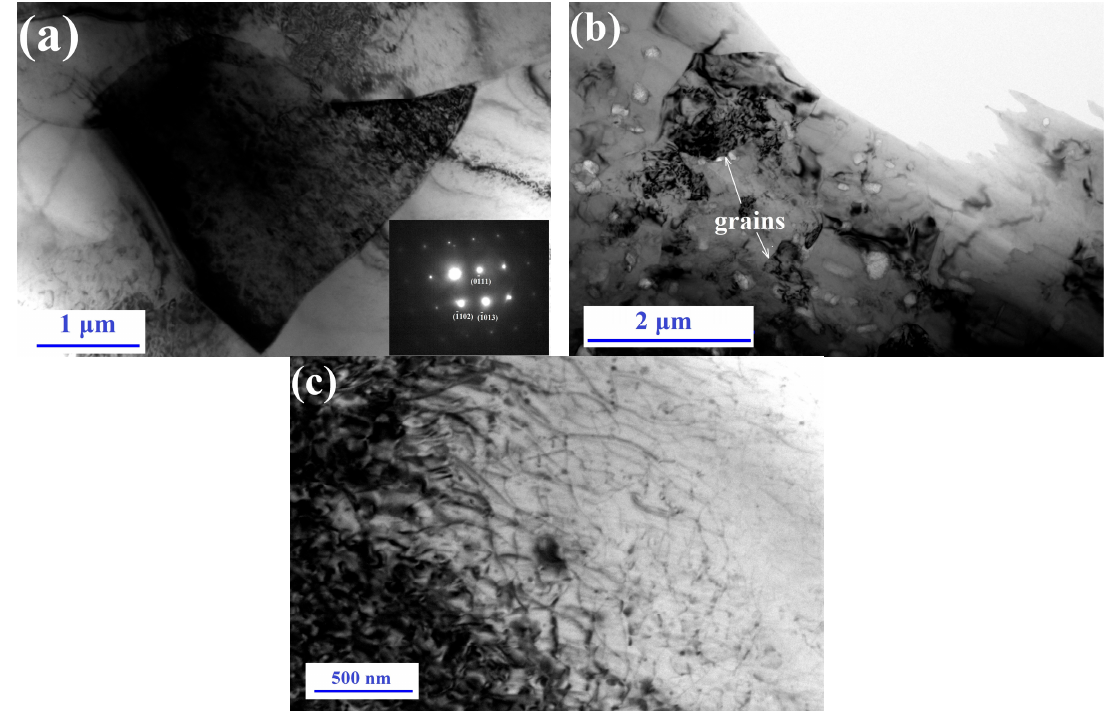
Figure 7. TEM microstructure of the Mg-9Li alloys: ( a ) 8-passes ECAPed (E8) alloy grain morphology; ( b ) E8R alloy grain morphologies; ( c ) intragranular dislocations of the E8R alloy.